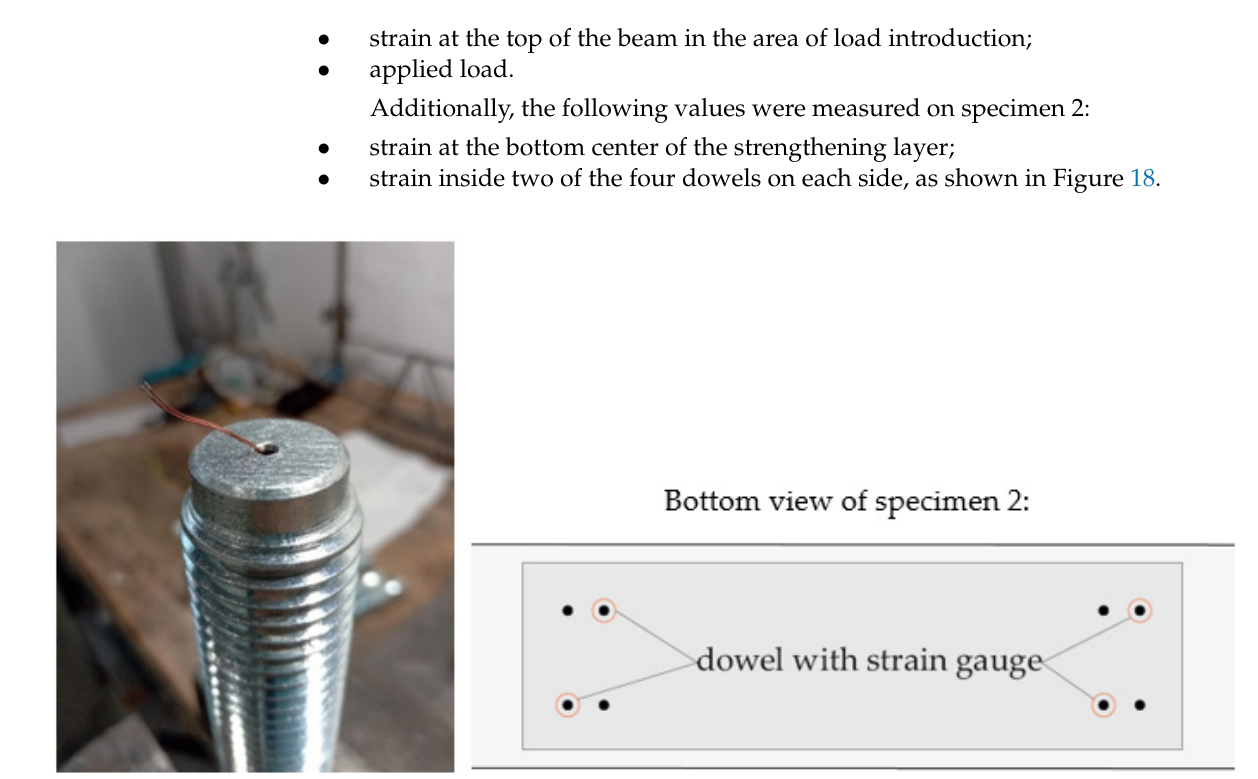
( b ) Figure 19. Planned load regime: ( a ) specimen 1; ( b ) specimen 2. (Graphic: HTWK Leipzig).